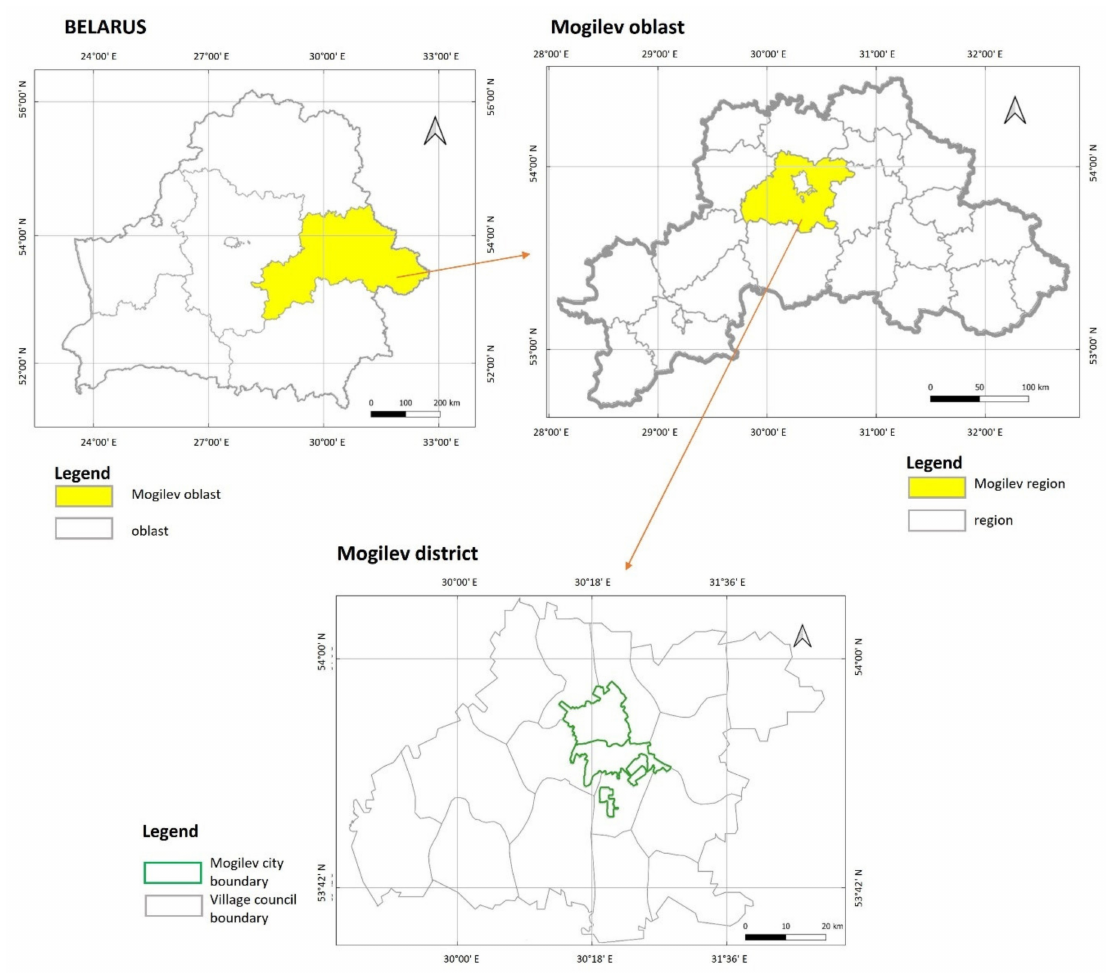
Figure 2. Location of the research